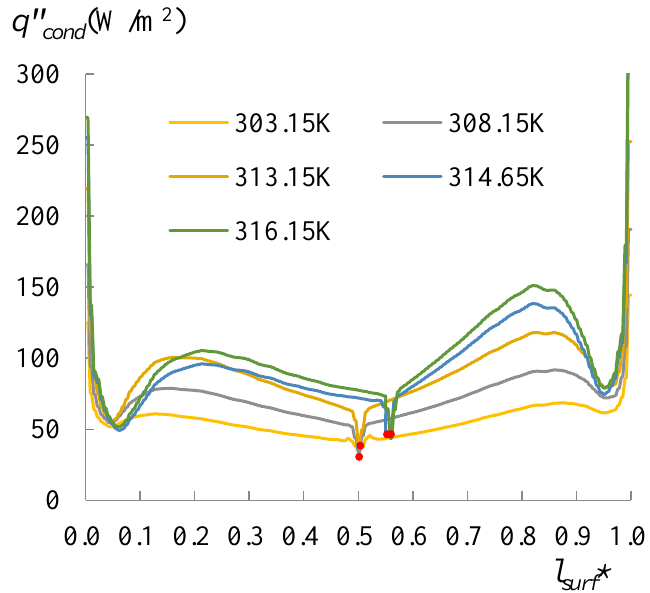
Figure 13. The heat flux conducted from droplet surface to the air for T s = 303.15 to 316.15 K. As well as the movement of the position of the lower heat flux, it also shows that the heat flux was higher on the right side than on the left side.